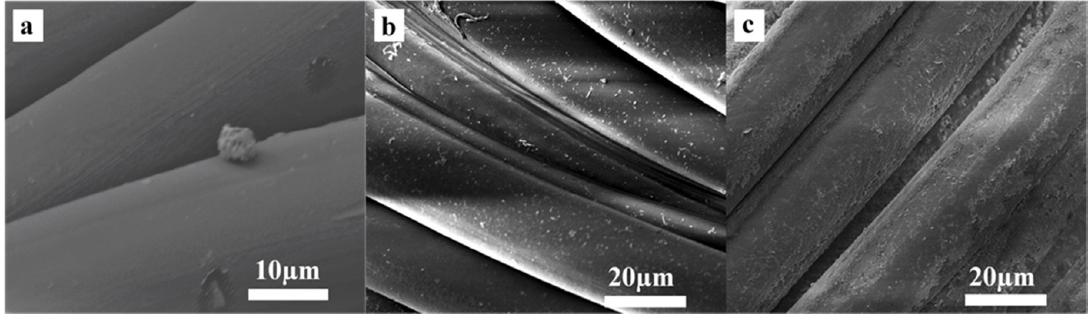
Figure 3. SEM images of PA fibers ( a ), modified by PA- g -PS 66 -Br ( b ), and PA- g -[(PS 66 -TEMPO)- mixed brushes -PDMAEMA 119 -Br] ( c ).